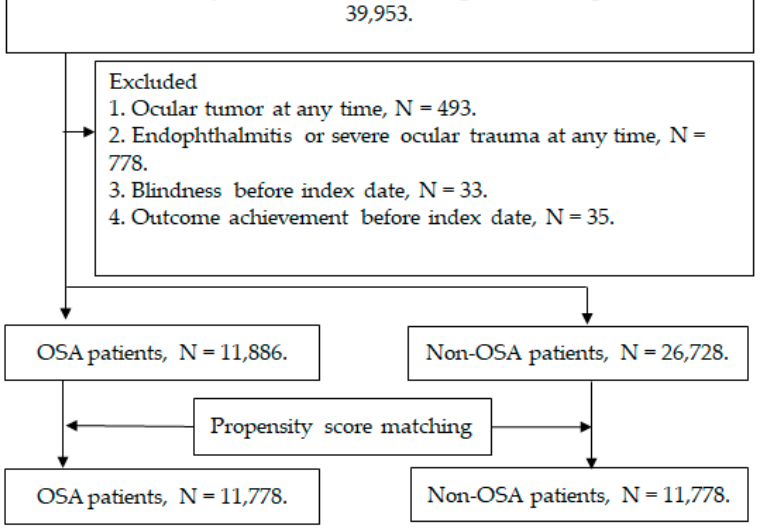
Figure 1. The flow chart of subject selection. N: number, OSA: obstructive sleep